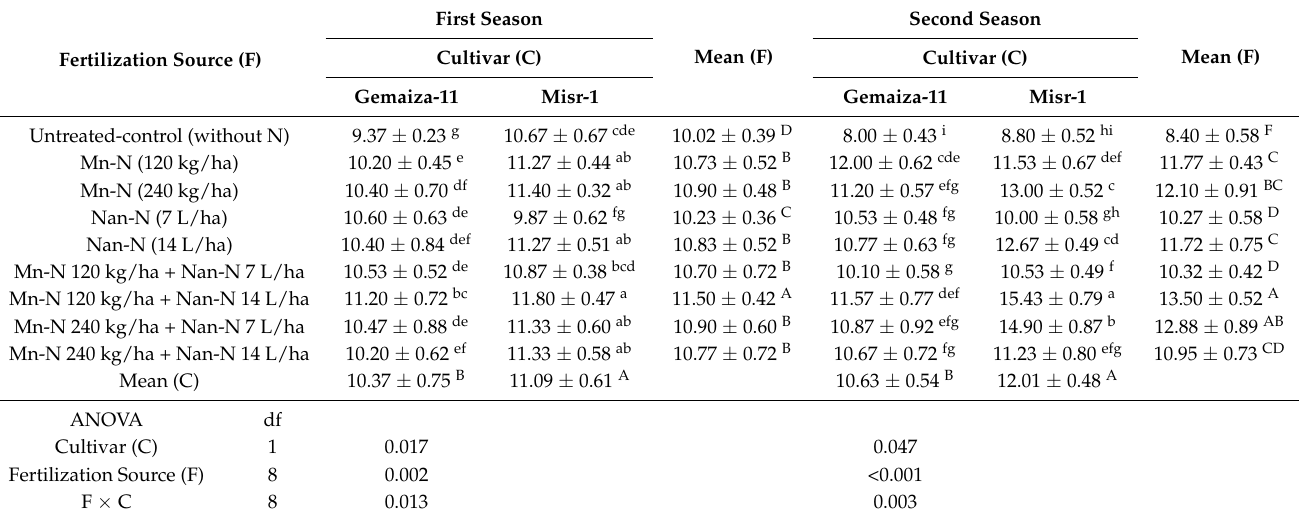
Table 4. Impact of nano- and mineral nitrogen fertilizers on the spike length (cm) of two wheat cultivars during the 2019/2020 and 2020/2021 seasons.